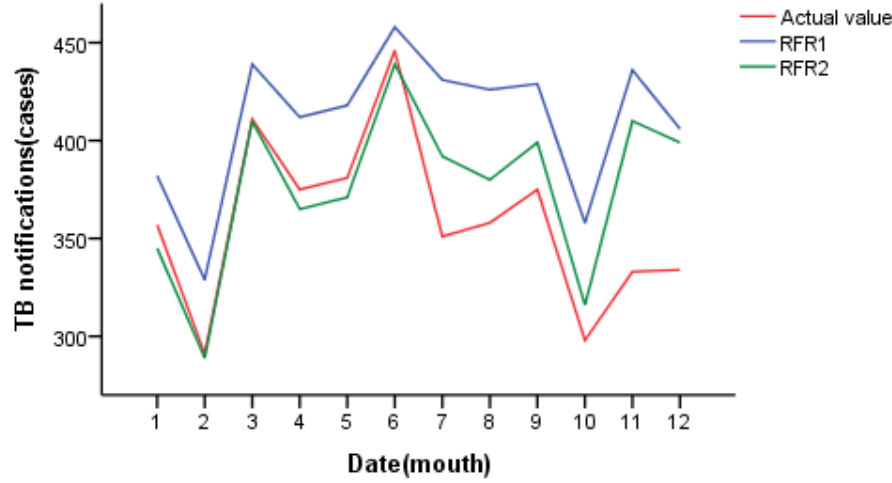
Figure 6. Prediction results of random forest regression (by monthly statistics).